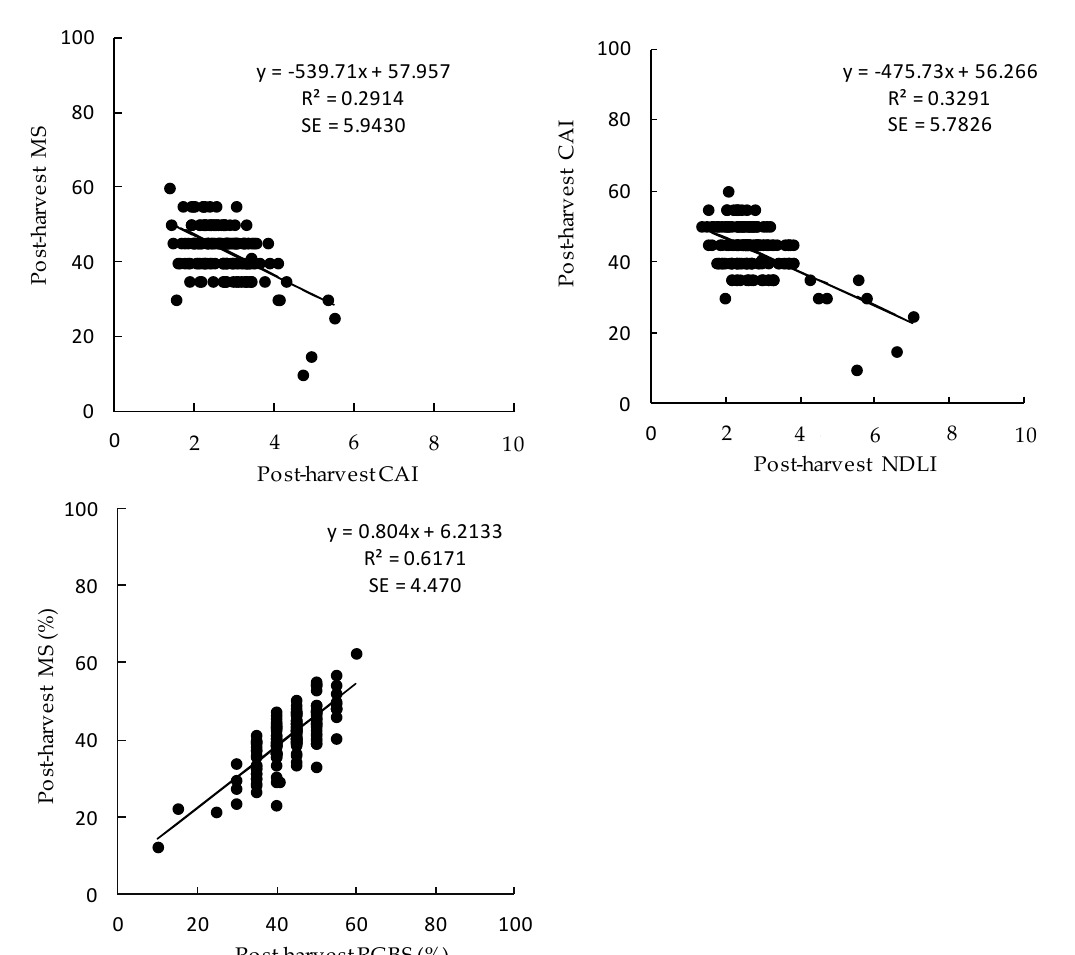
Figure 8. Linear regression for bare ground prediction, n = 162, where MS is manual soil area, RGBSF is RGB image-based soil area, CAI is cellulose absorption index, and NDLI is normalized difference lignin index .